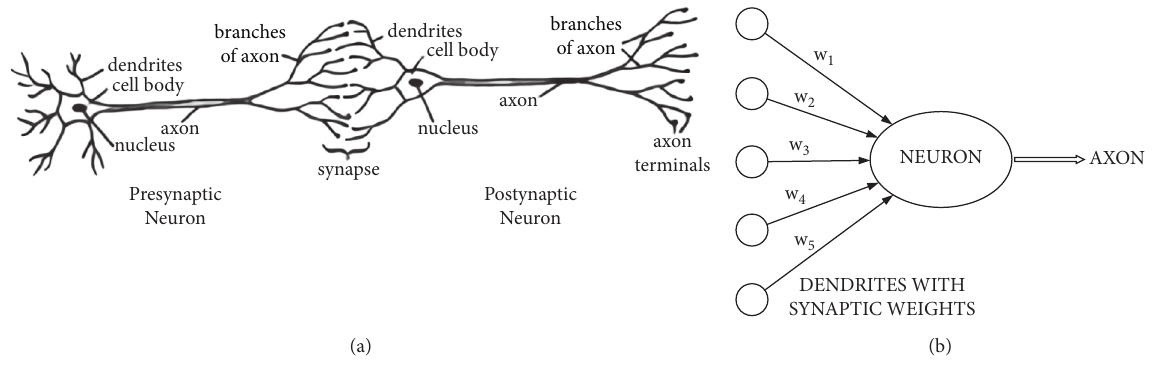
Figure 2: Biological neural network and artificial neural network